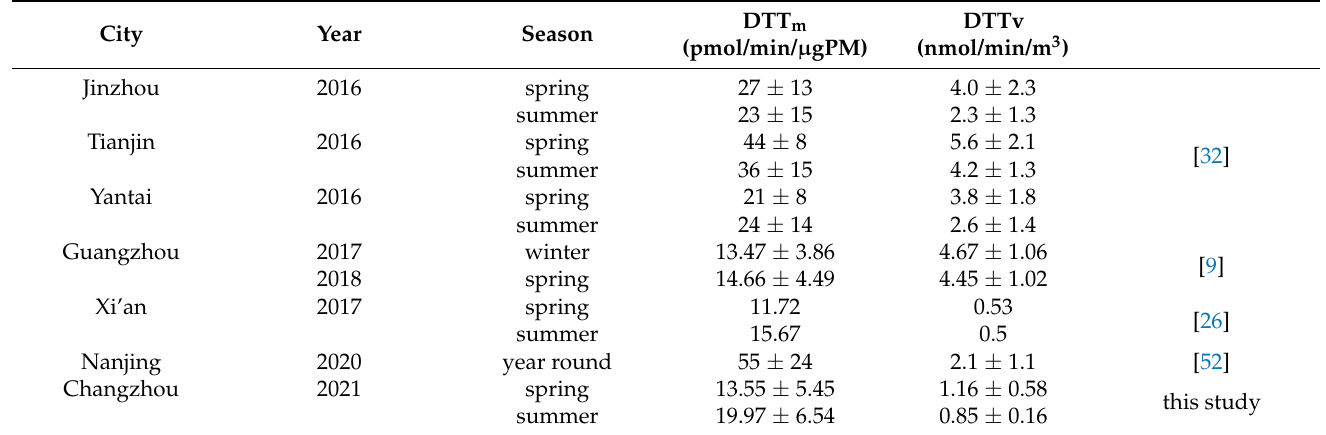
Table 2. Literature summary of DTTv and DTTm in atmospheric